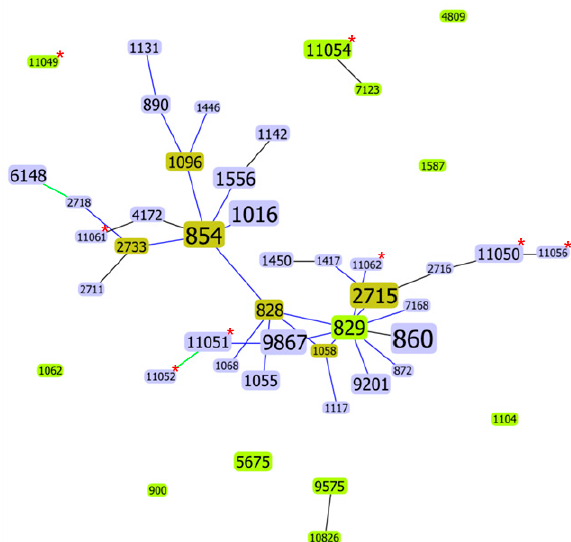
Figure 1. goeBURST analysis conducted at a single locus variant level, with double locus variants added to show further relatedness. Light green ST nodes, group founder; dark green ST nodes, subgroup founder; light blue ST nodes, common node; and red asterisks, novel STs. Colored links: black, link drawn without recourse to tiebreak rules; blue, link drawn using tiebreak rule 1; and green, link drawn using tiebreak rule 2.